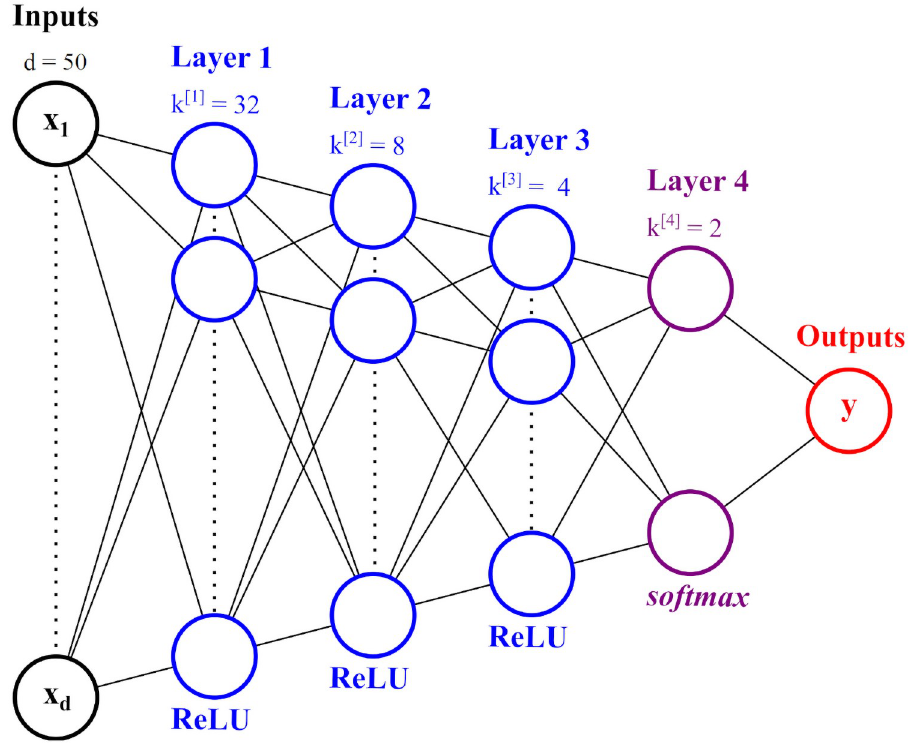
Fig 12. The ANN neuron architecture used in the Mount Polley case